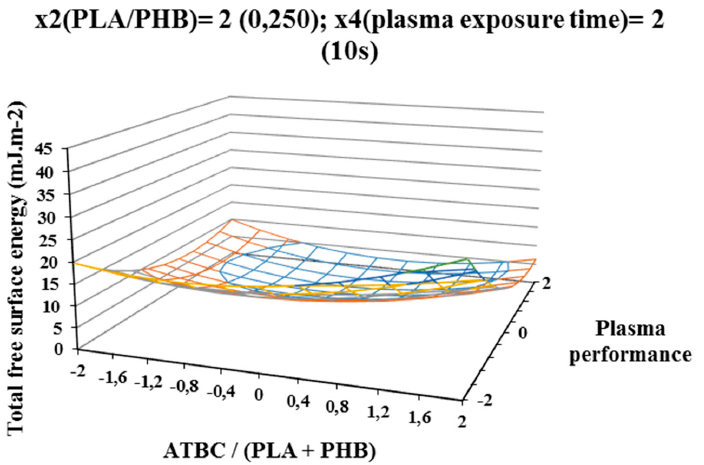
Figure 9. Response surface of total free surface energy di ff erence measured 5 h after plasma surface treatment in dependence of factors x1 (ATBC / (PLA + PHB)) and x3 (plasma power) at constant factor x2 (PHB / PLA) = 0 and x4 (plasma exposure time)) = 0.